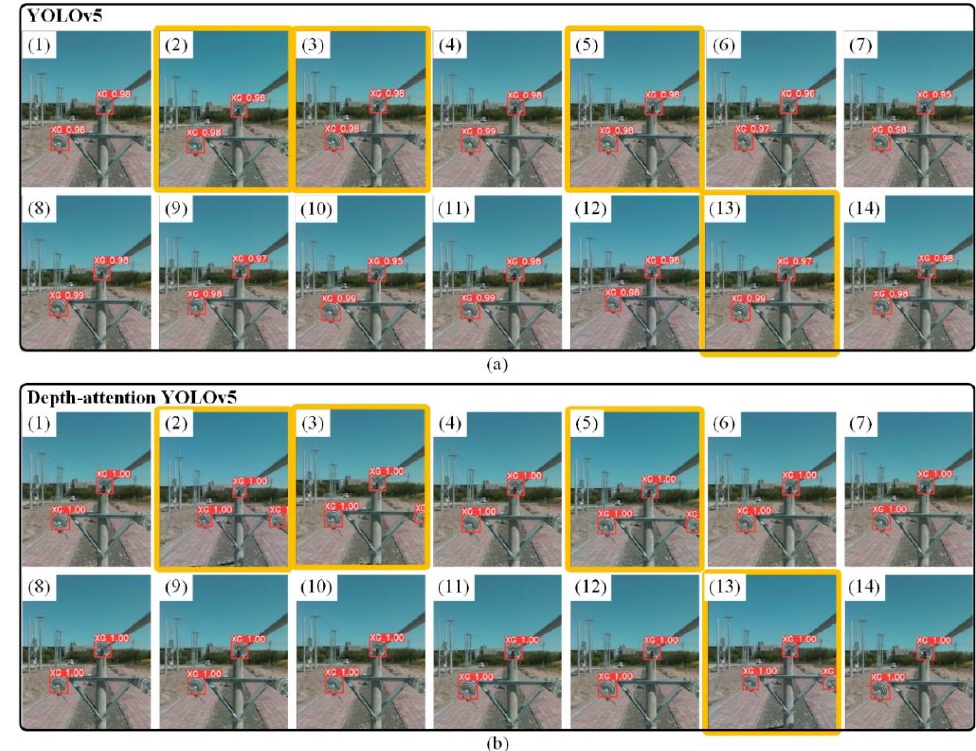
Figure 26. Recognition results on the line test dataset. ( a ) YOLOv5; ( b ) depth-attention YOLOv5.